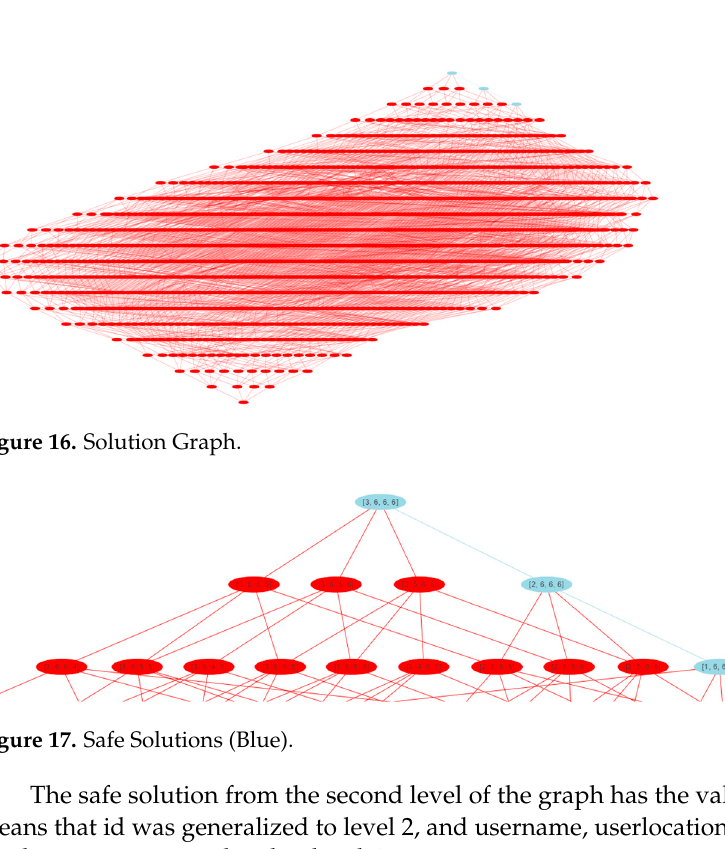
Figure 17. Safe Solutions (Blue).